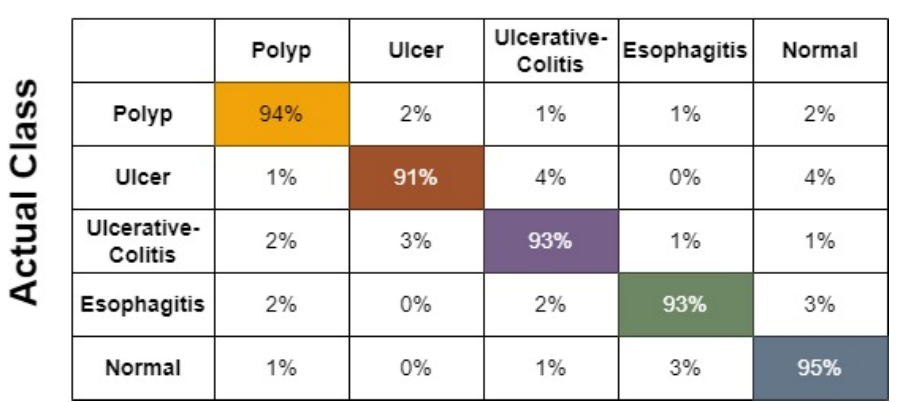
dataset (original images + augmented contrast enhanced images).